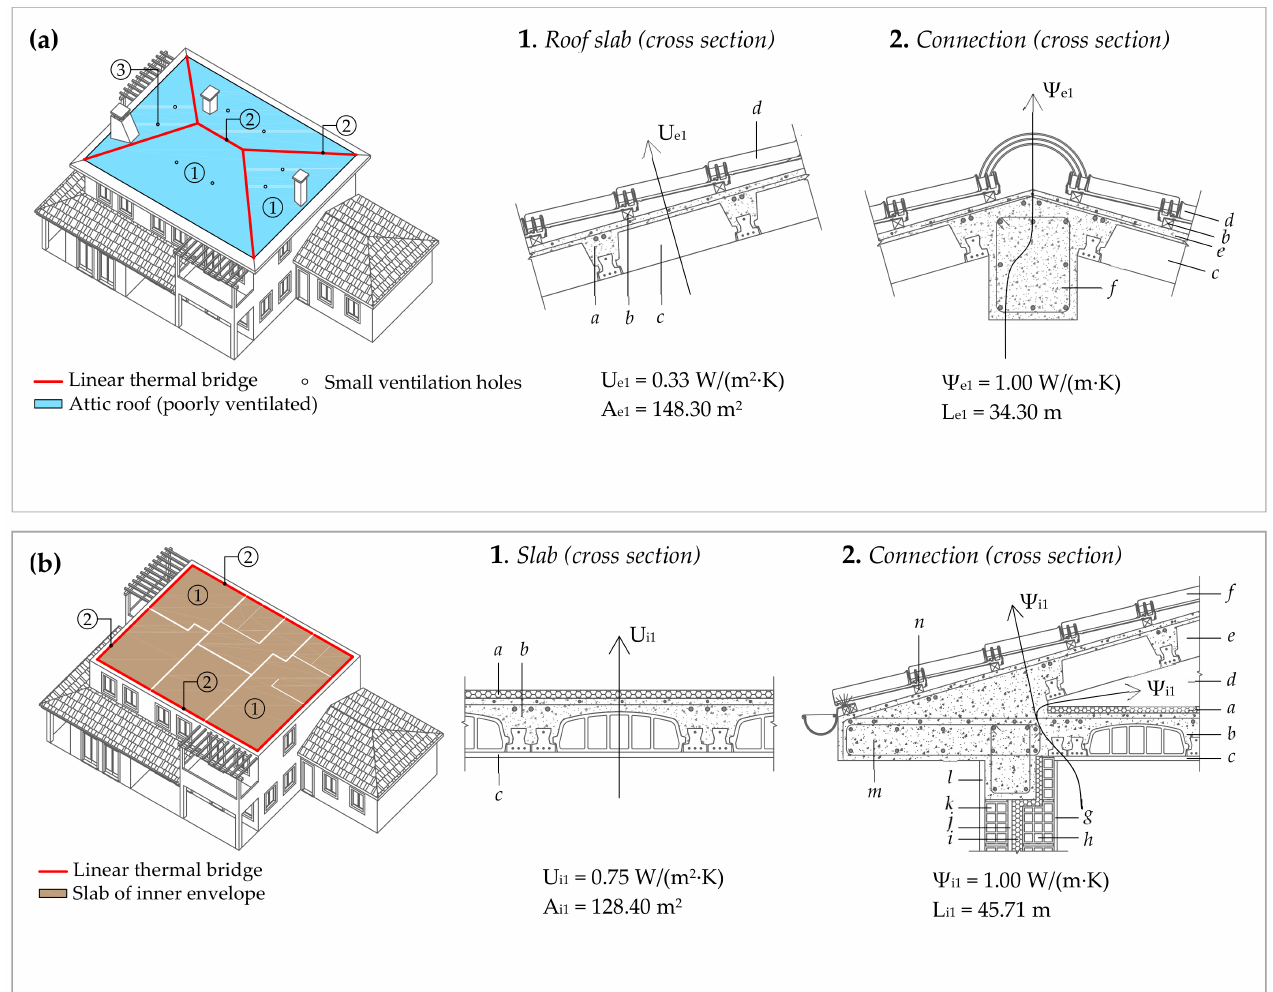
Figure 3. Characterization of the thermal envelope of Attic 1: ( a ) the sloping roof slab